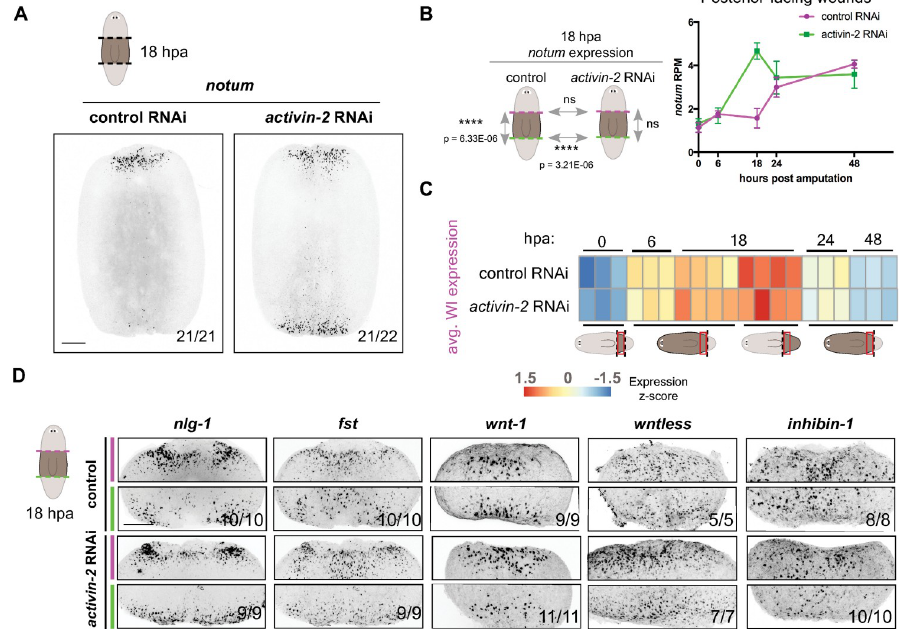
Fig 3. activin-2 is required for asymmetric activation of notum at anterior-versus-posterior wounds. (A) FISH shows loss of wound-induced notum asymmetry (polarity) in activin-2 RNAi animals at 18 hpa. (B) Cartoons show results from DESeq analyses: no significant difference between wound-induced notum expression at anterior- and posterior-facing wounds in activin-2 RNAi animals, and increased notum expression at posterior-facing wounds in activin-2 RNAi animals compared to controls at 18 hours post amputation. ns, not significant. Graph shows notum reads per million at posterior-facing wounds over time. (C) Heatmap shows expression of wound-induced genes as described [22] from bulk mRNA-seq of posterior-facing wounds at 0, 6, 18, 24, and 48 hours post amputation, and anterior-facing wounds at 18 hours post amputation. Cartoons show the wounds described in the heatmap. (D) FISH shows no difference in muscle wound-induced gene expression between control and activin-2 RNAi animals. Magenta, anterior-facing wound; green, posterior-facing wound. All images are anterior up. Scale bars, 200 μ